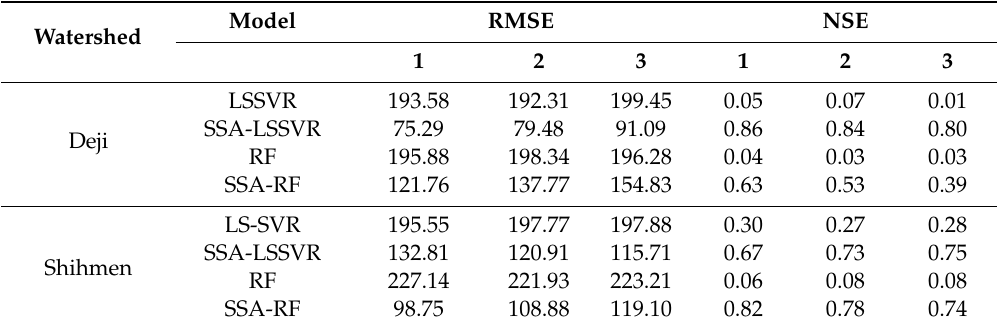
Table 4. Forecasting performances of the LS-SVR and SSA-LSSVR models during the validation period.